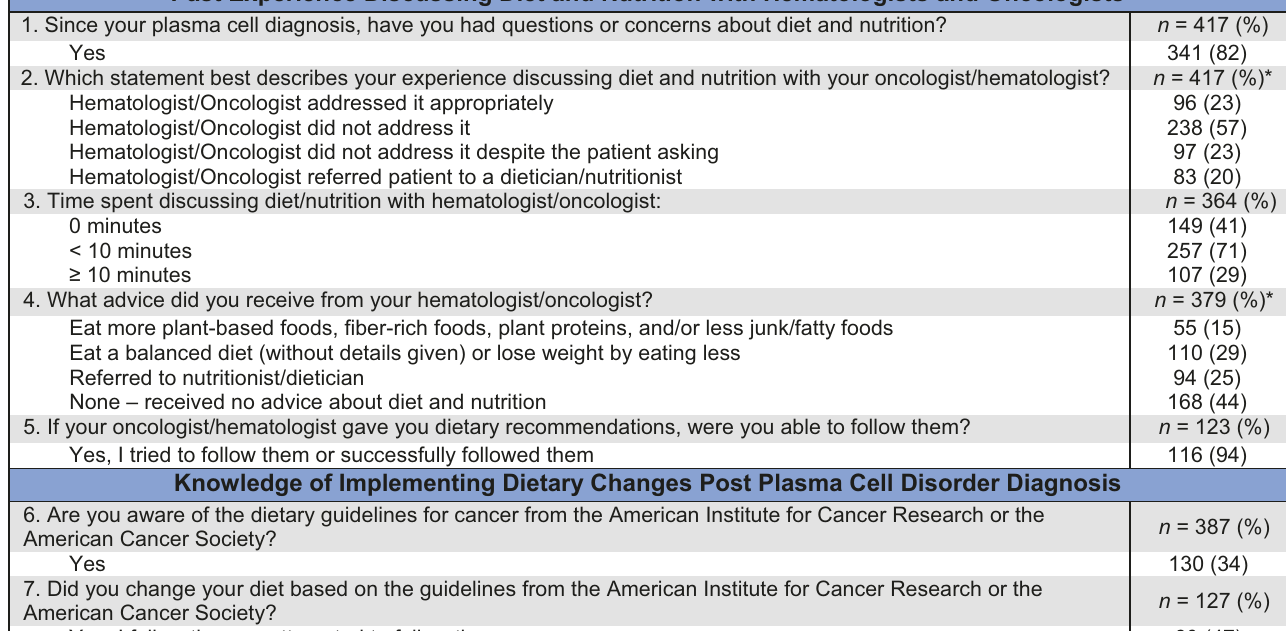
Table 1. Perceptions and Experiences with Hematologists and Oncologists Regarding Diet and Nutrition. Past Experience Discussing Diet and Nutrition with Hematologists and